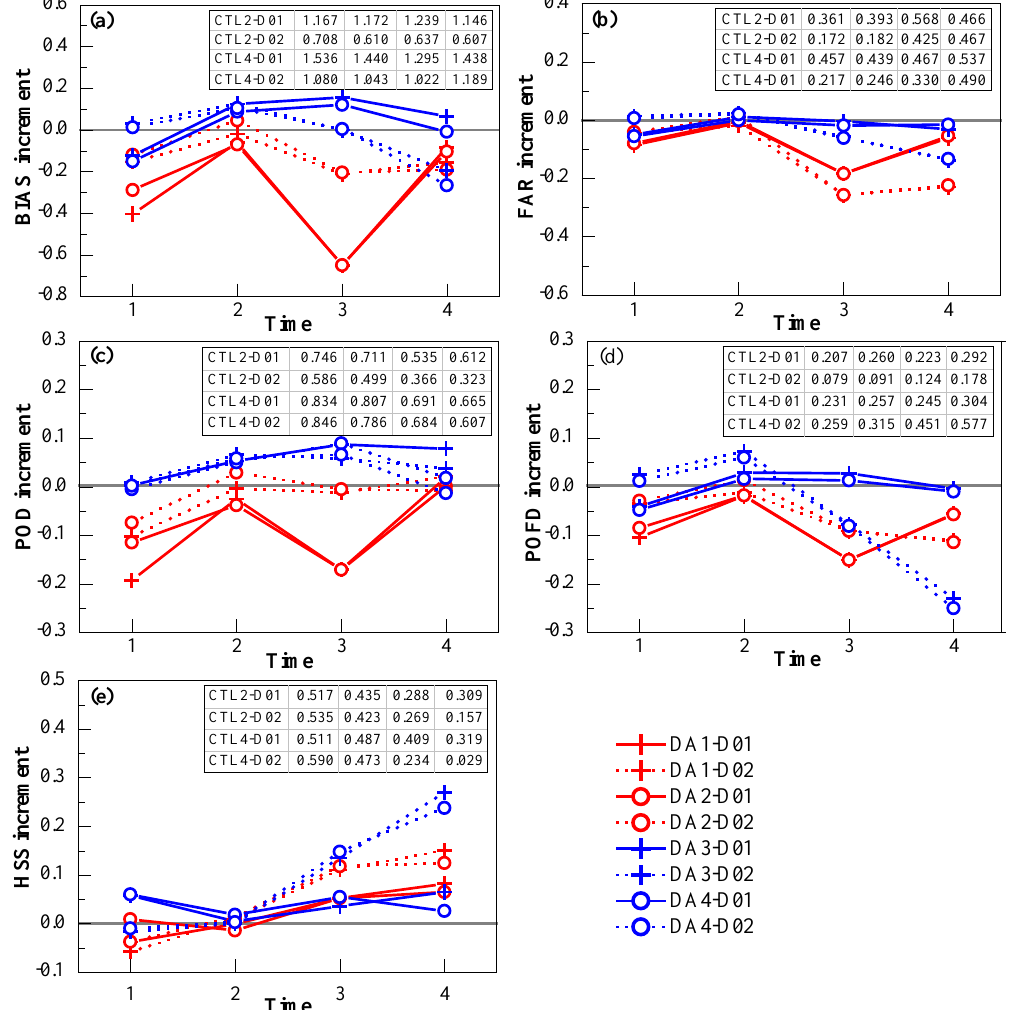
Figure 11. Increments of skill scores of BIAS ( a ), FAR ( b ), POD ( c ), POFD ( d ), and HSS ( e ) in the DA experiments compared to their corresponding CTL experiments. The table in each graph lists the evaluation scores of CTL2 and CTL4. The x-axis represents the first, second, third, and fourth 12-hour periods in the overall study period.